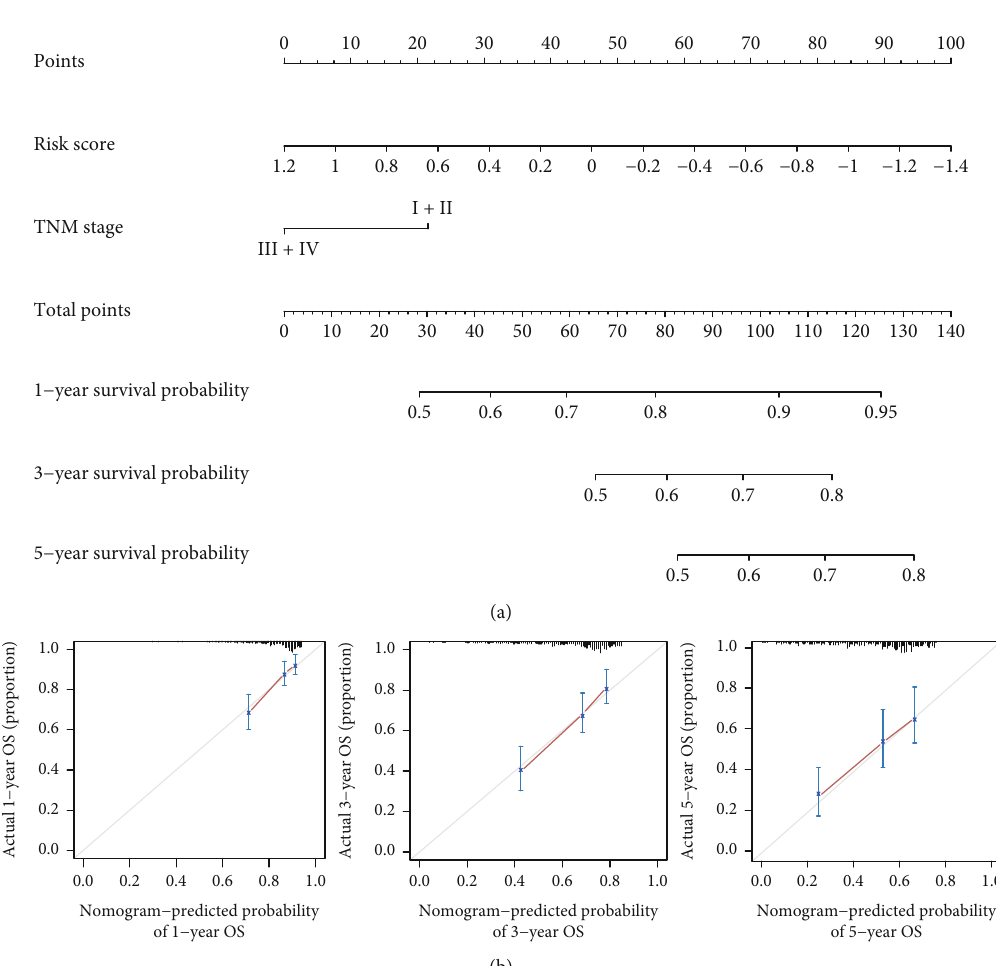
Figure 6: The established nomogram exhibited good predictive ability. This nomogram was generated using a combination of risk scores and TNM stage to predict HCC patient OS (a). Calibration charts corresponding to the prediction of 1-, 3-, and 5-year survival in the training cohort. Horizontal and vertical axes, respectively, correspond to the predicted and actual survival probability